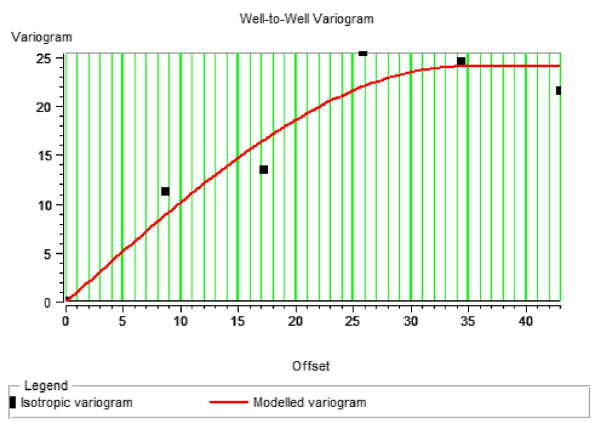
Fig. 24 Variogram obtained from well data for the third category of data